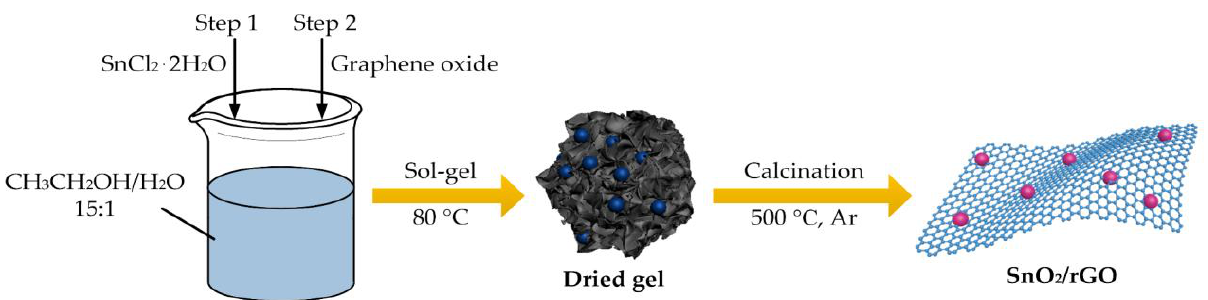
Figure 1. Illustration of preparation procedure of SnO 2 /rGO by sol-gel method.